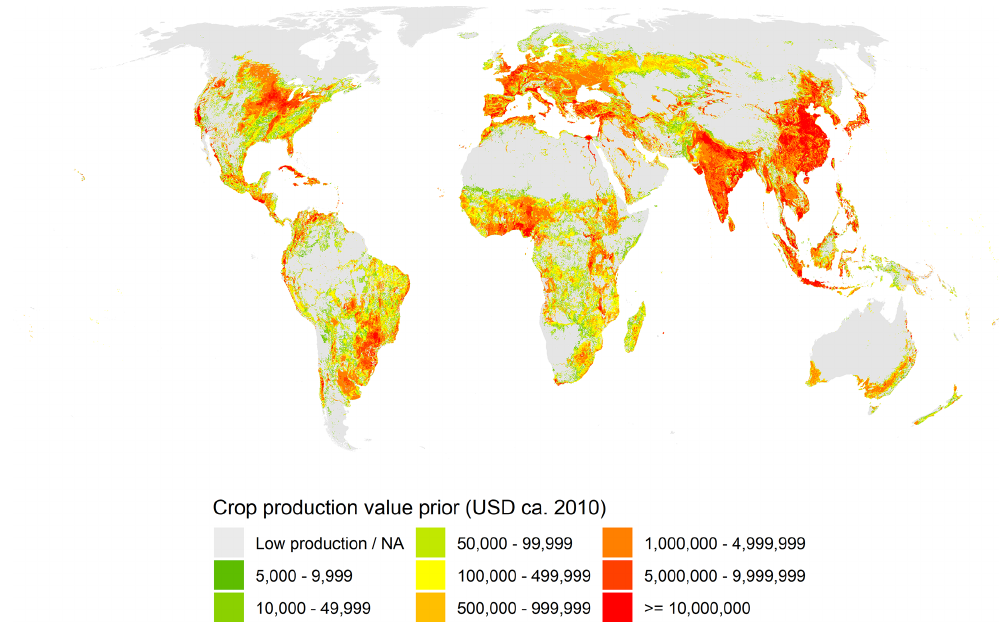
Figure 1. The assembled crop production value used as a prior in the cross-entropy model (FAO, 2016; Yu et al., 2020).